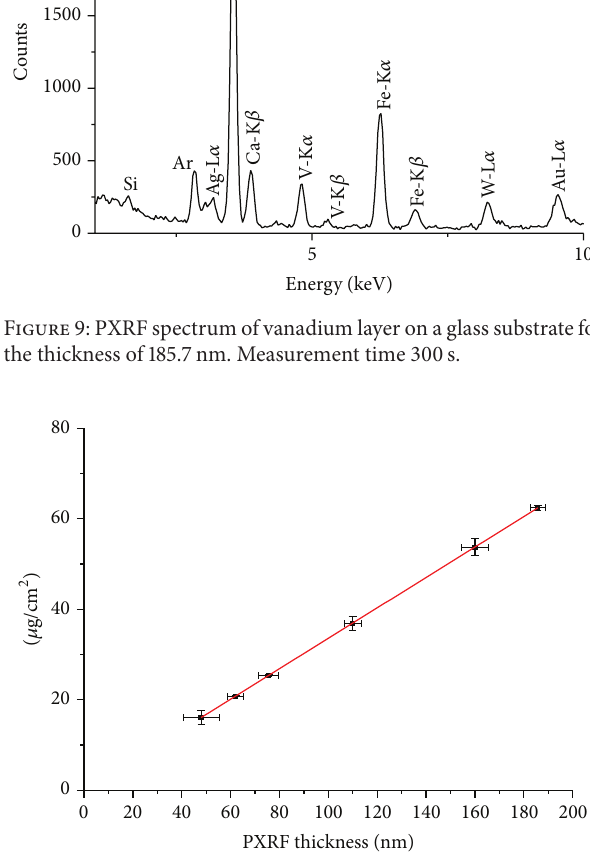
Figure 10: Thickness determined by PXRF for all the samples of V 2 O 5 versus that determined by the deposited